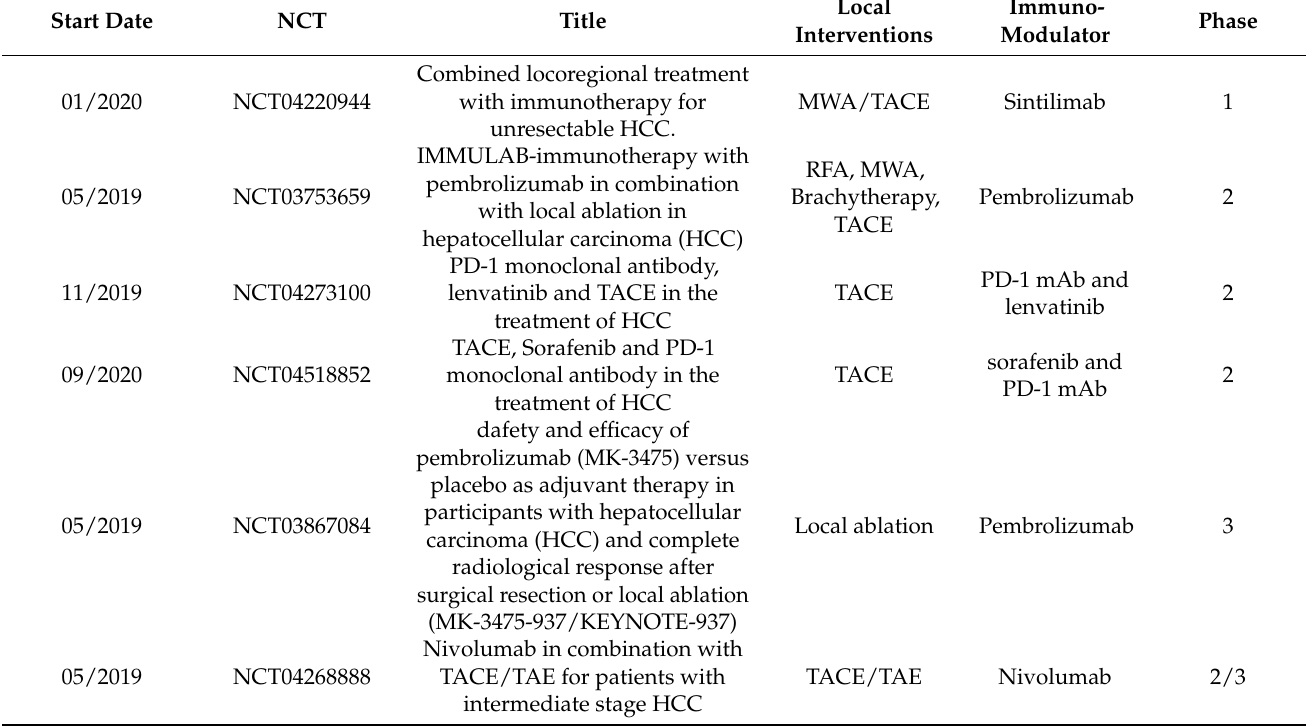
Table 2. Ongoing studies investigating the combination of locoregional therapies and